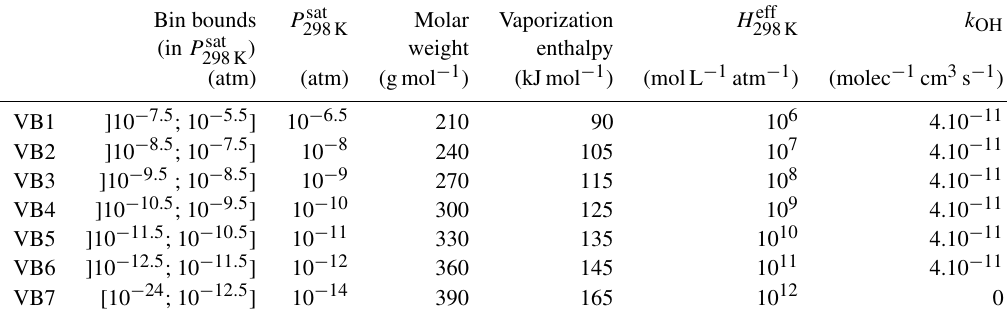
Table 2. Properties of the seven bins of the VBS-GECKO parameterization.